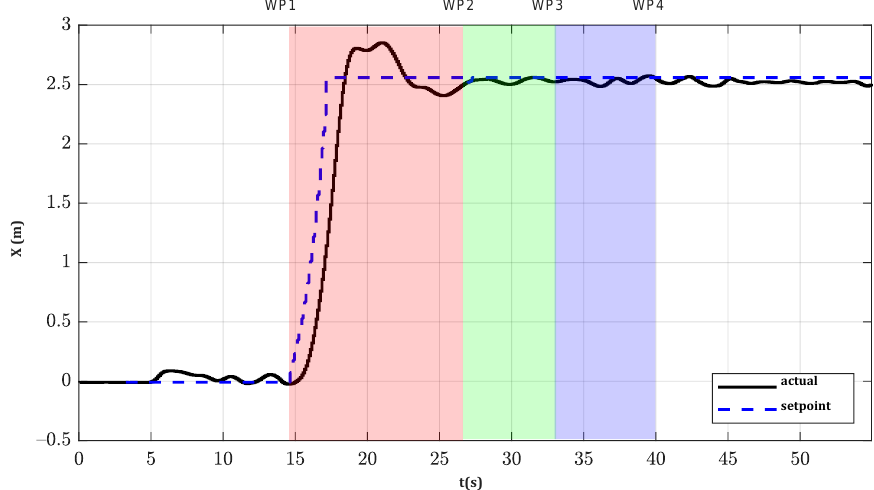
Figure 10. X -axis motion during one of the -axis motion during one of the trials. Figure 10. -axis motion during one of the trials. Figure 10. 𝑋𝑋 𝑋𝑋